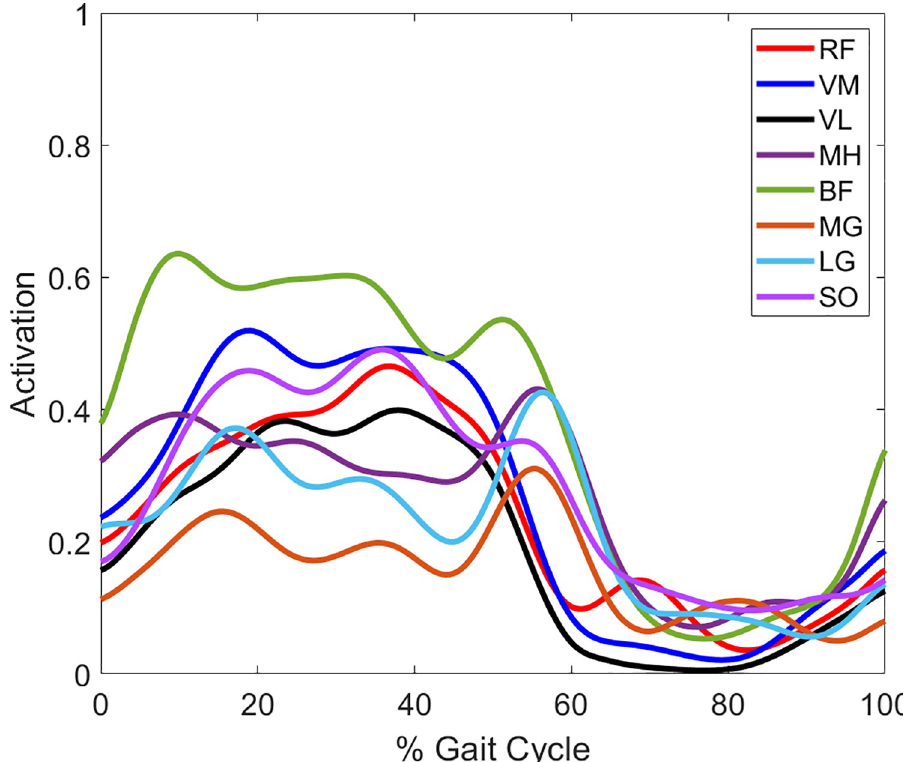
Fig 8. Average muscle EMG for the KOA participant with one module (KOA 10). Muscle abbreviations: rectus femoris (RF), vastus medialis (VM), vastus lateralis (VL), medial hamstrings (MH), biceps femoris (BF), medial gastrocnemius (MG), lateral gastrocnemius (LG), soleus (SO).